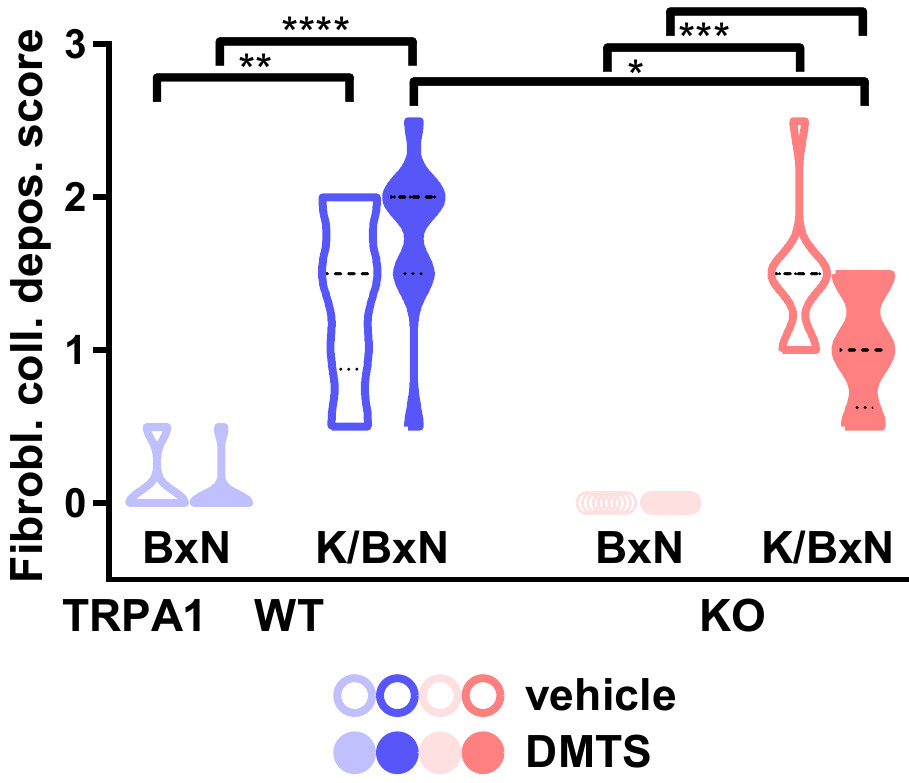
Figure 5. Amounts of fibroblasts and collagen deposition were smaller in arthritic TRPA1 KO mice treated with DMTS than in WT ones. The amounts of fibroblasts and collagen deposition were scored on decalcified hematoxylin and eosin-stained slides of tibiotarsal joints of hind legs. Width of violin plots corresponds with frequency density of the data. Open violin plots represent vehicle-treated groups; solid ones indicate animals injected with DMTS. Dashed lines show medians and dotted lines display quartiles. Kruskal–Wallis test followed by Dunn’s test: n = 8–10. * p < 0.05, ** p < 0.01, *** p < 0.001, **** p < 0.0001 vs. indicated group.